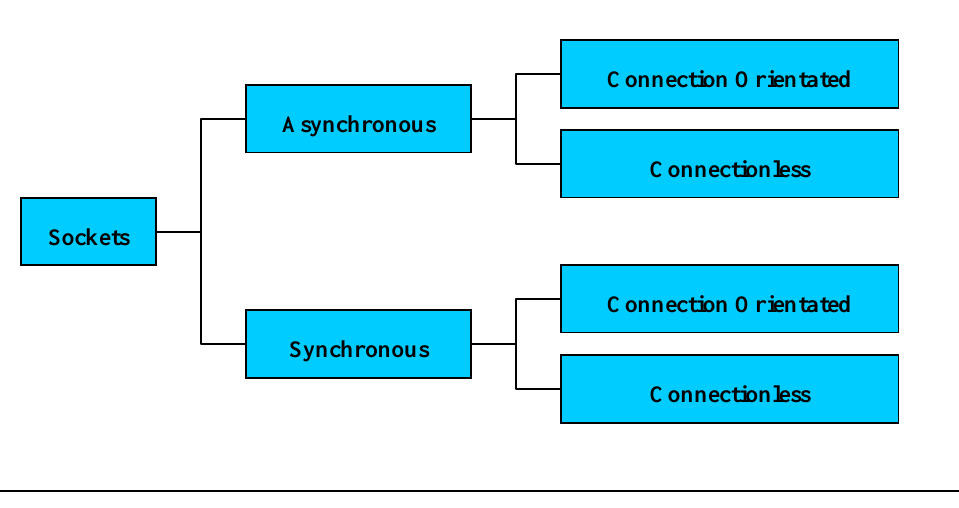
Figure 8. Types of